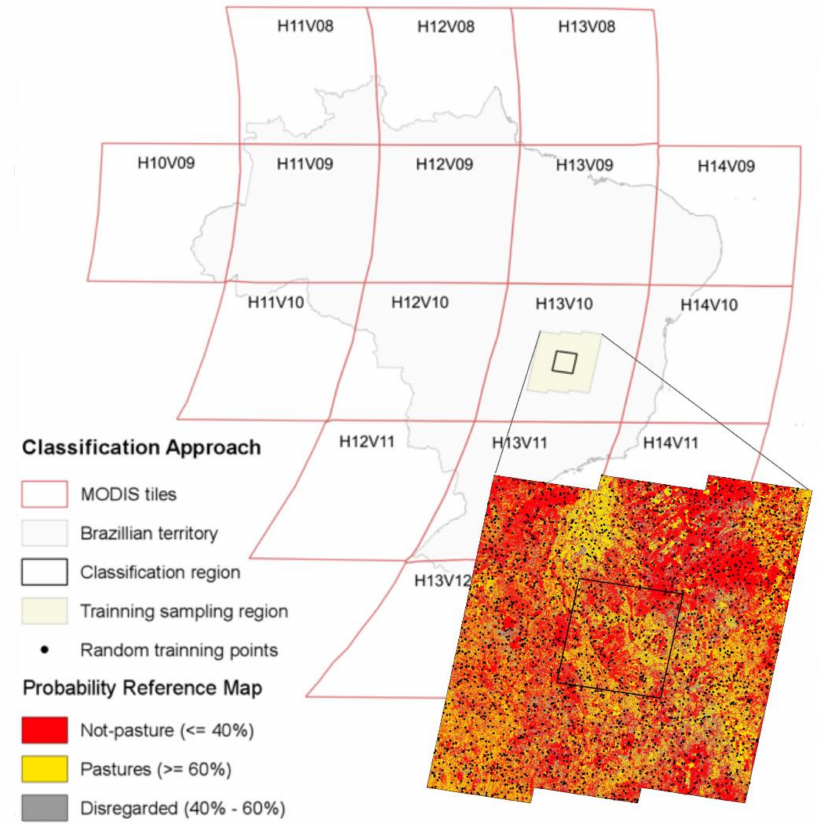
Figure 1. The stratified classification approach for mapping the Brazilian pasture areas, considering 16 MODIS tiles and the respective limits of 380 Landsat World Reference System (WRS)-2 regions. For each classification region, a total of 2700 training points (from the central WRS-2 path and row and eight neighboring regions), were randomly selected over a reference probabilistic map [13], considering both pasture (probabilities ≥ 60%) and not-pasture areas (probabilities ≤